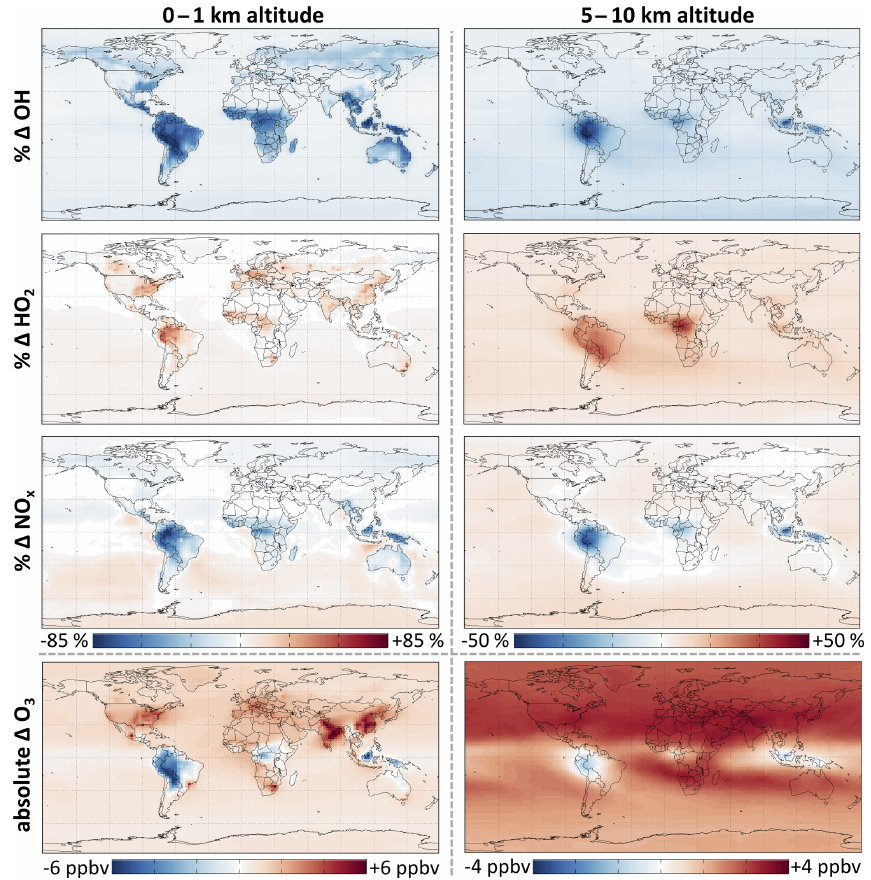
Figure 7. Effects of RCIM isoprene chemistry on OH, HO 2 , NO x , and ozone concentrations. The figure shows annual mean differences in GEOS-Chem simulations with versus without isoprene